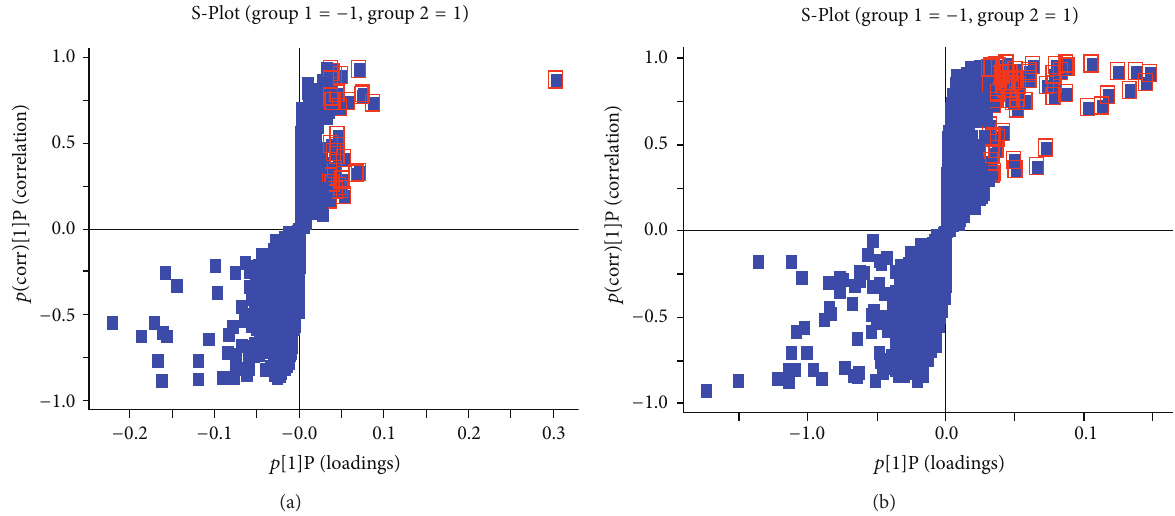
Figure 4: S-plots of human serum samples between C and SHLI groups in (a) positive ion mode and (b) negative ion mode. The ions marked with box were at the higher level in SHLI group.